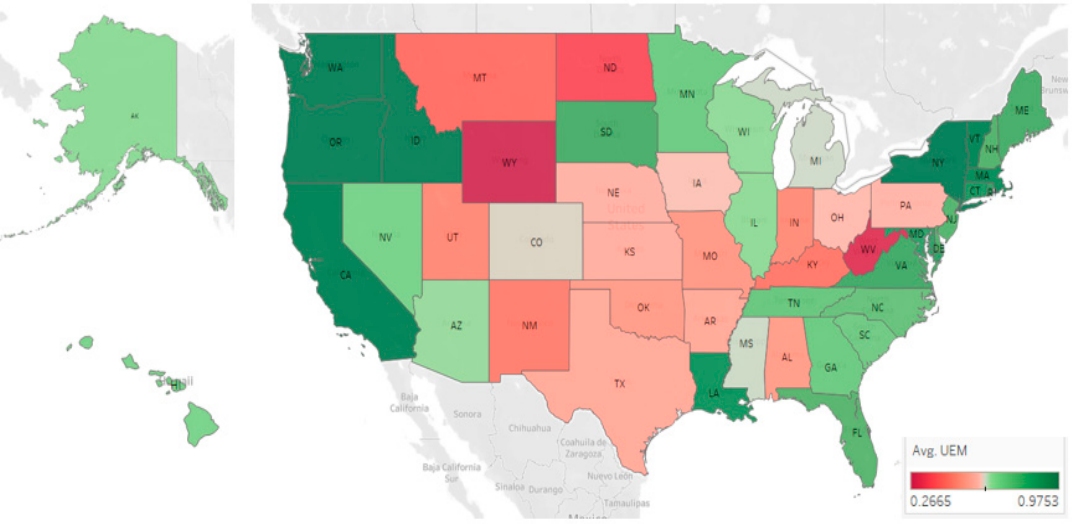
Figure 1. Average Unified Efficiency Scores of Fifty States over Period of 2009–2018.